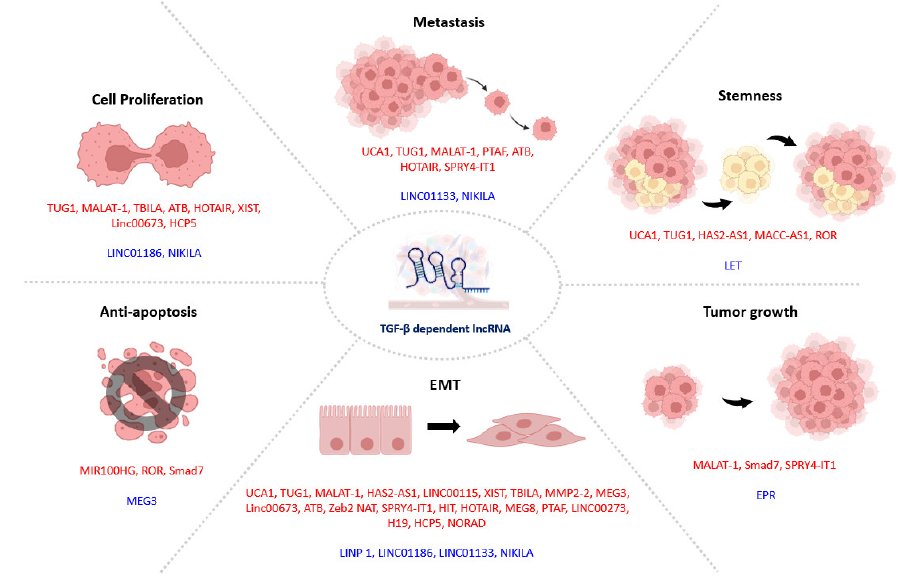
Figure 2. Diverse mechanisms of TGF-β-dependent lncRNA in cancer progression. Pleiotropic TGF-β regulates tumor progression via inducing pathogenic (red) and protective (blue), which modulate cancer cell activities from the early to the advanced stages. Notably, stemness of cancer cells largely contributes to treatment resistance and